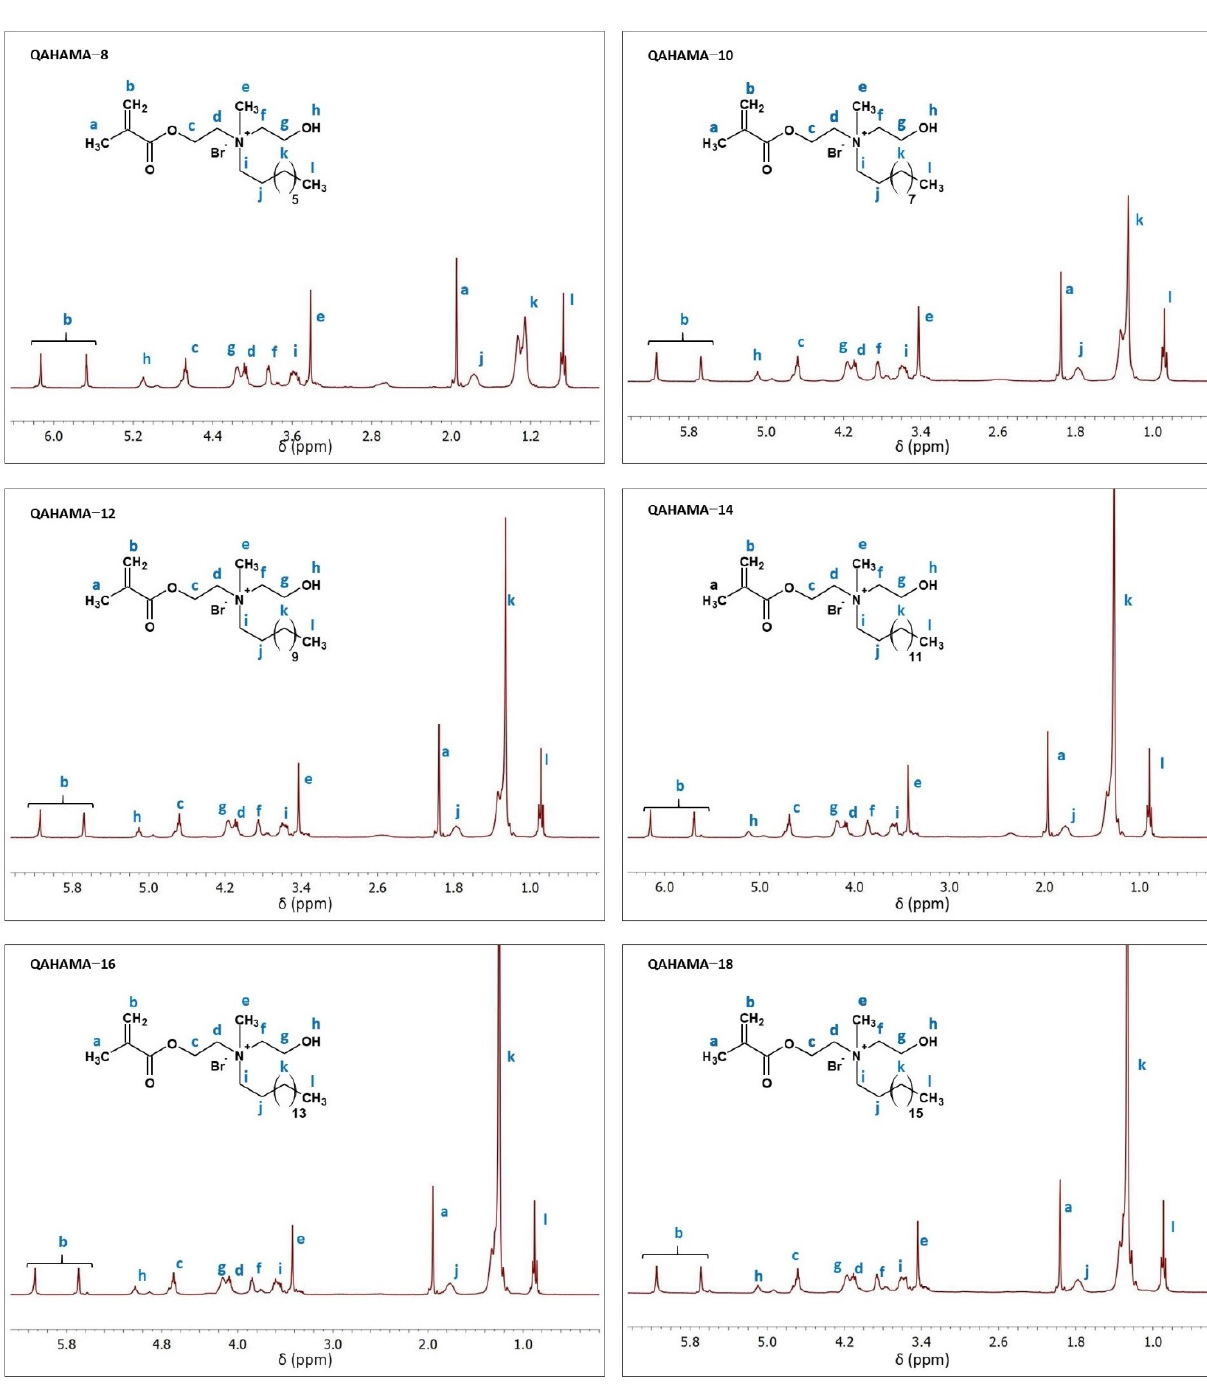
Figure 3. 1 H NMR spectra of QAHAMAs.